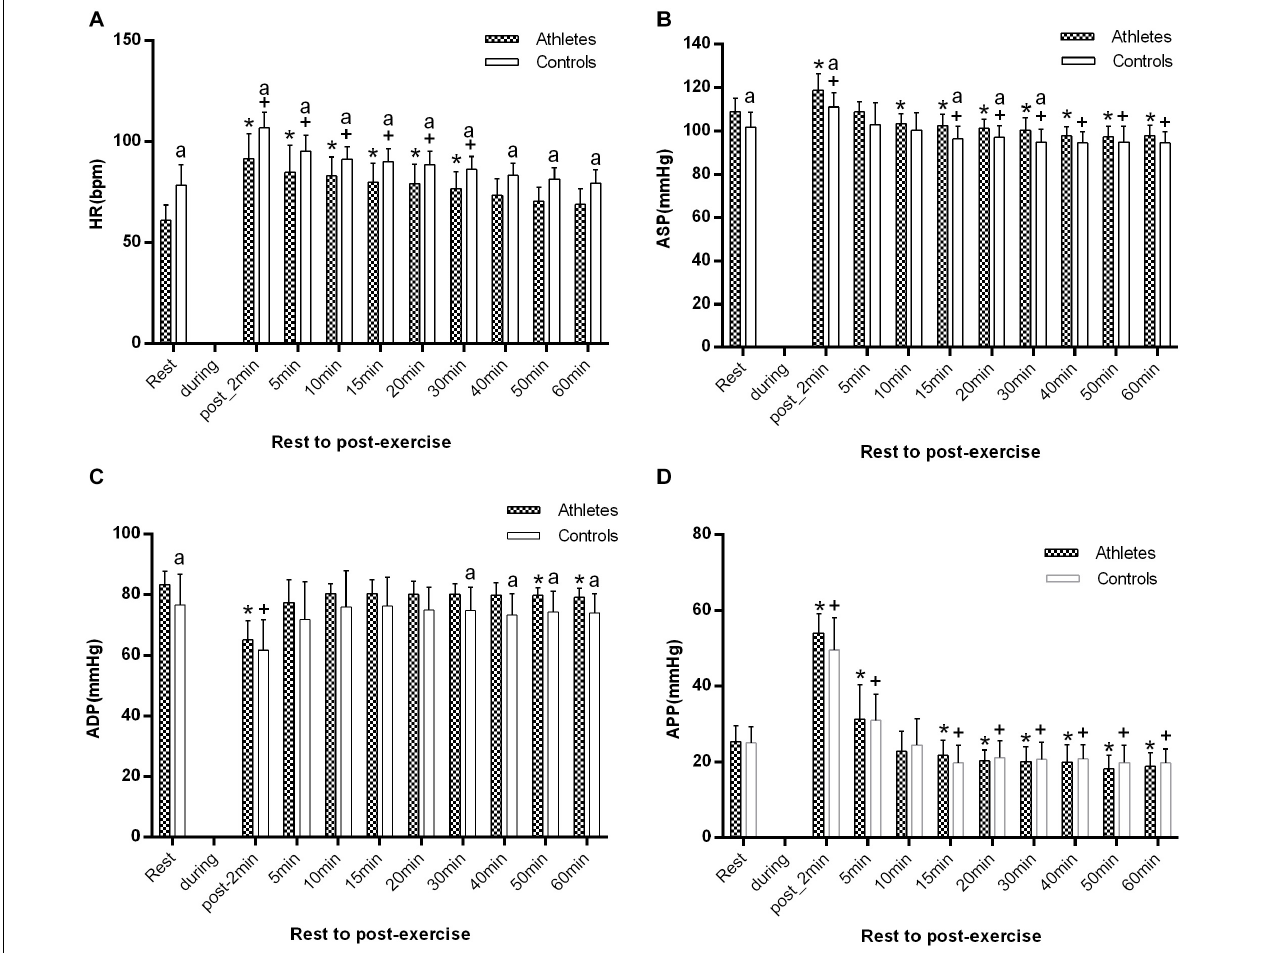
FIGURE 3 | The difference of HR (A) , ASP (B) , ADP (C) , and APP (D) between athletes and controls at pre-exercise and 1–2, 5, 10, 15, 20, 30, 40, 50, and 60 min after exercise. The error bars represent the between-participant standard deviation ( SD ). The “ a ” indicates significant difference between the two groups with p < 0.05; The “*” and “ + ” indicate significant difference between pre- and post-exercise with p < 0.05 in athletes and controls,